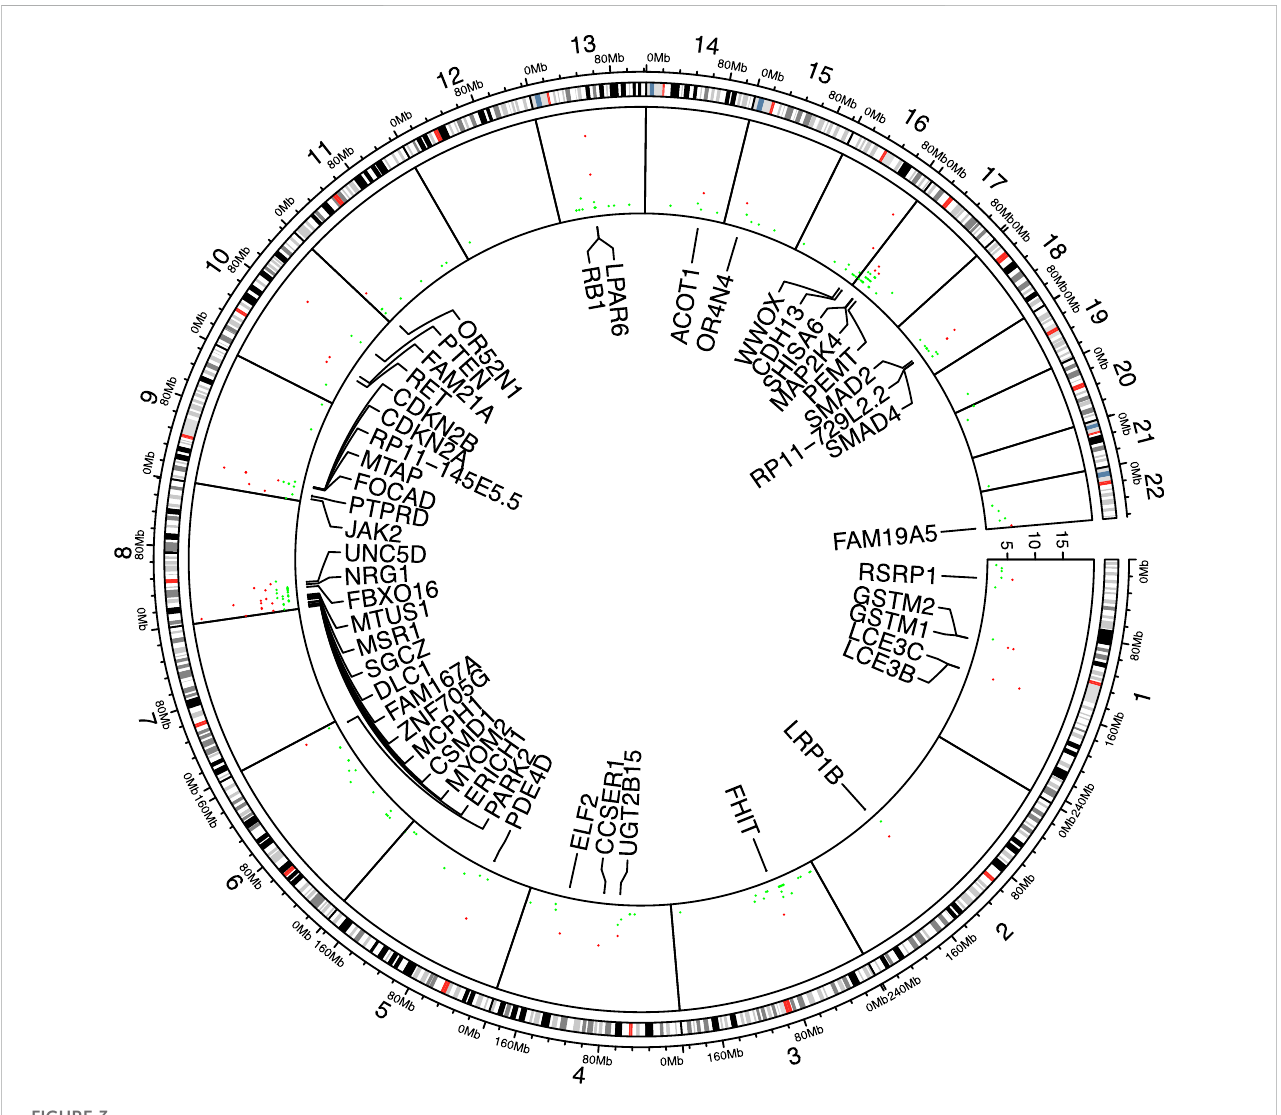
FIGURE 3 Signi fi cant genes shared among analyses. 49 genes found signi fi cant in more than fi ve analyses are marked red and labeled accordingly.